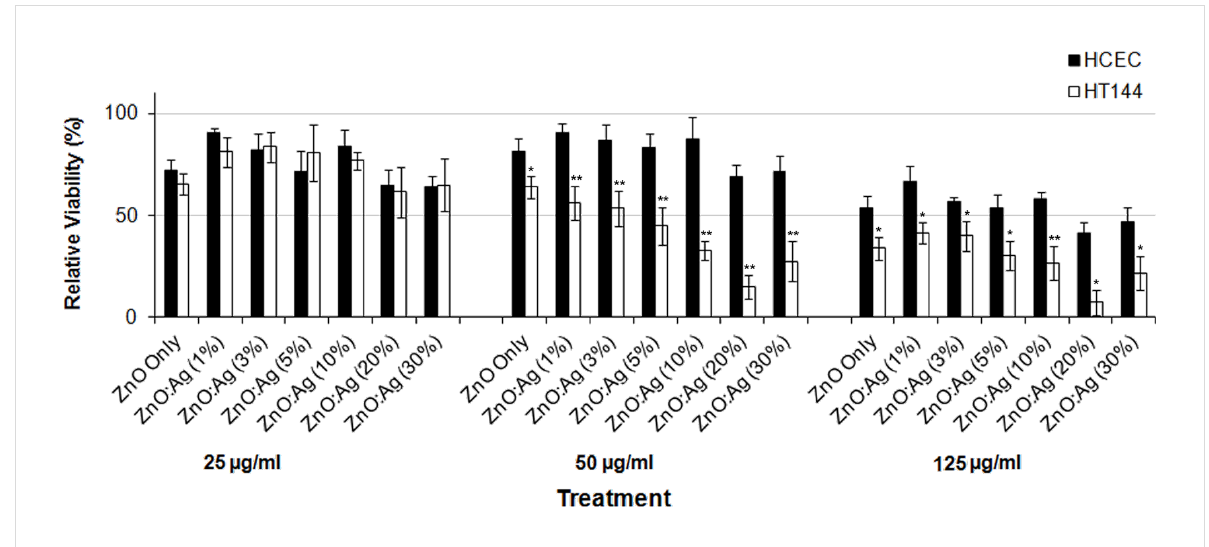
Figure 4: Effect of ZnO and ZnO:Ag nanocomposites on the viability of HT144 (skin cancer) and HCEC (normal) cells using SRB assay. Exponen- tially growing cultures were treated with different concentrations of the nanoparticles (25, 50, and 125 µg/mL) for 24 h. Percent viabilities (mean ± SD) were calculated relative to NTC. * p < 0.001, ** p < 0.0001 (two tailed t-test) when compared to HCEC.